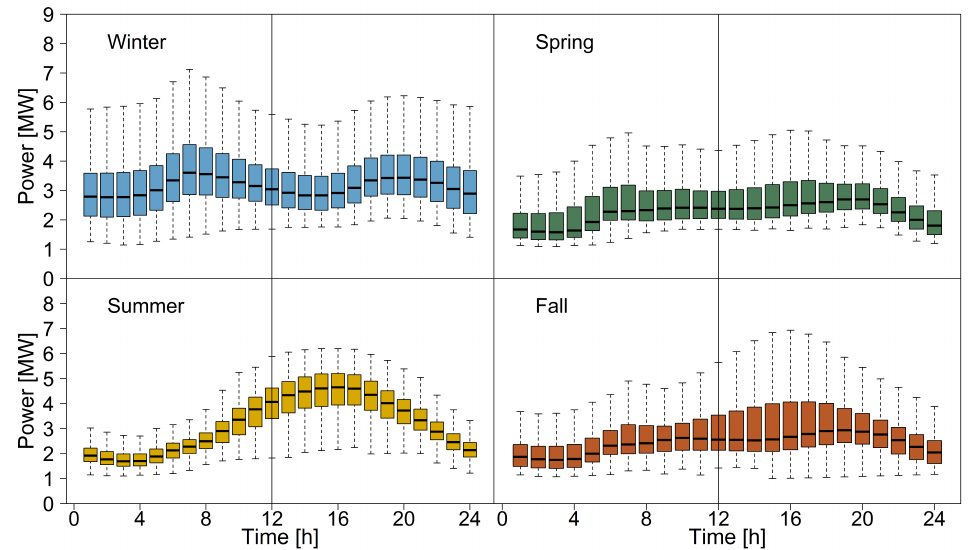
Figure 2. Hourly box plots show the distribution of the measured total electric power in 2017–2019 for the example residential community considered in the study across an entire day for all four seasons. The expected impact of season on total electricity used is illustrated, hence inclusion of weather parameters in